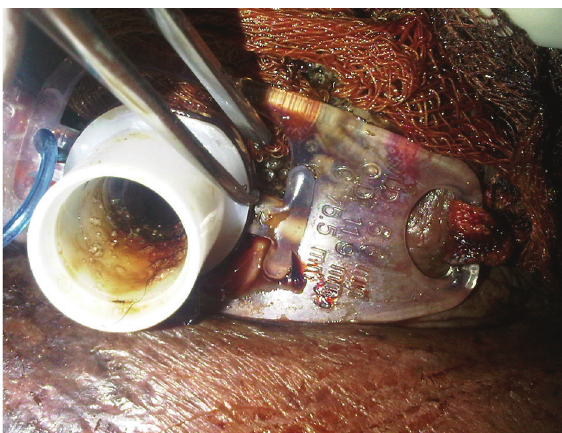
Figure 2: Maggots being removed from around the stoma.